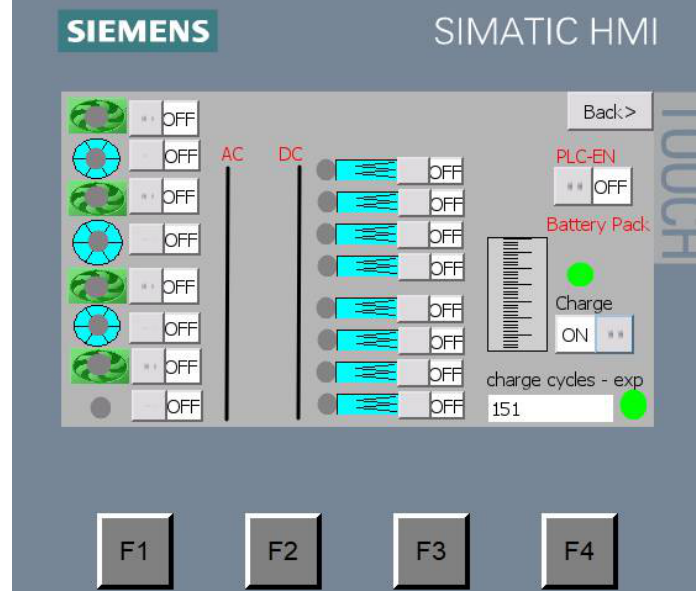
Figure 12. HMI of PLC controller interface.